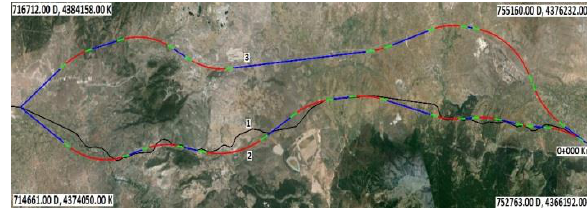
Figure 2. Routes for the existing and improved conventional line for Implementation 2